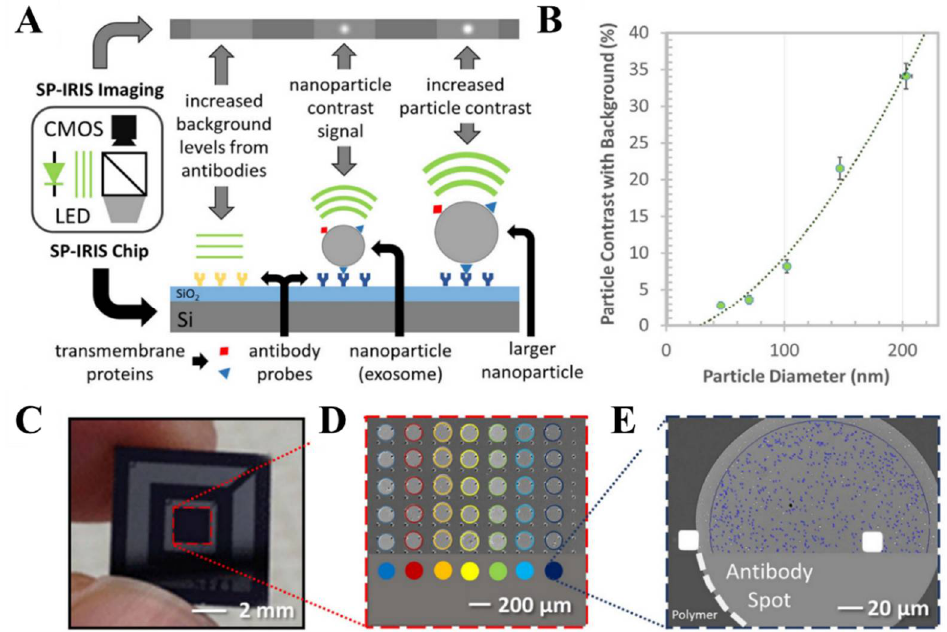
Figure 7. Schematic representation of the single particle interferometric imaging sensing (SP-IRIS) detection process. ( A ) Detection principle of SP-IRIS technique. ( B ) SP-IRIS signal for polystyrene nanoparticles (50–200 nm). ( C ) Image of a SP-IRIS chip. ( D ) Microarray of immobilized capture probes. ( E ) SP-IRIS image of a capture probe. Reprinted with permission from [76]. Copyright 2016, Springer Nature.